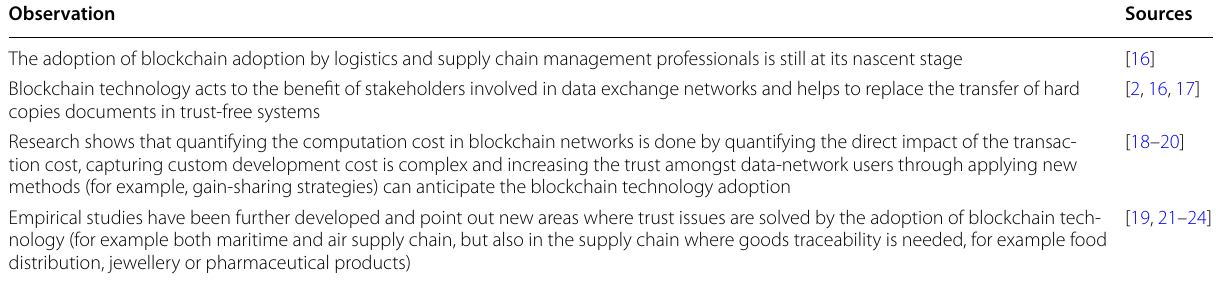
Table 1 Key research outcome regarding the state-of-the-art of blockchain research in supply chains. Source : own compilation